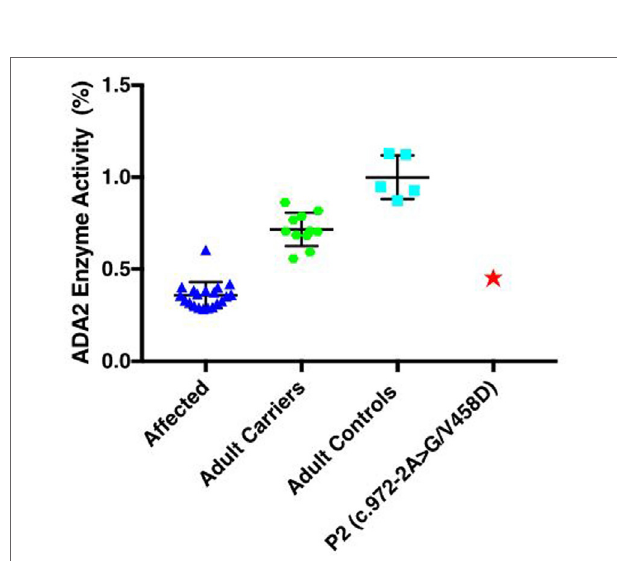
FIGURe 2 | Serum ADA2 enzyme activity and cDNA sequencing to confirm pathogenic mutations: enzymatic activity (%) was significantly lower in the affected Patient 2 when compared to age-matched controls ( n = 5) and heterozygous carriers ( n = 11), but similar to other patients with DADA2 ( n = 20). Samples were not available for